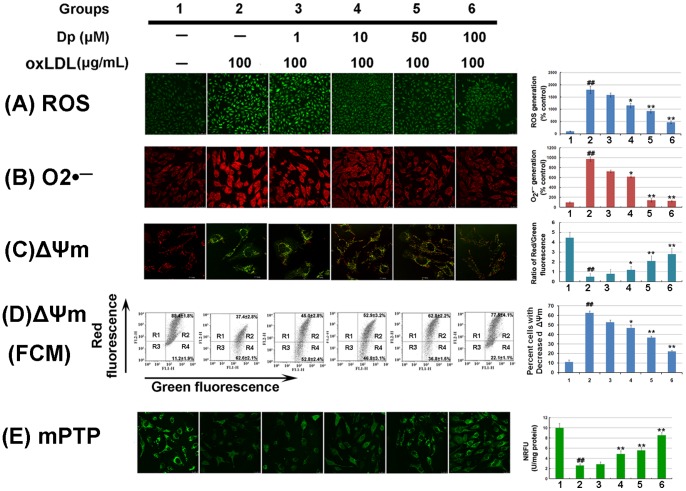
Effects of Dp on mitochondrial dysfunction in oxLDL-induced HUVECs.HUVECs were pretreated with various Dp concentrations (1, 10, 50 and 100 μM, respectively) for 2 h, and then exposed to 100 μg/mL of oxLDL for another 24 h. (A) Intracellular ROS levels were estimated using the probe DCFH-DA. Fluorescence was read at 485 nm for excitation and 520 nm for emission. (B) Intracellular O2
·− levels were estimated using the probe DHE. Fluorescence was read at 355 nm for excitation and 420 nm for emission. (C) Determination of ΔΨm was carried out using CLSM and fluorescences were determined by spectrophotometry assay. Red fluorescence is emitted by JC-1 aggregates in healthy mitochondria with polarized inner mitochondrial membranes, while green fluorescence was emitted by cytosolic JC-1 monomers and indicates ΔΨm dissipation. Merged images indicated the co-localization of JC-1 aggregates and monomers. The ΔΨm in each group was calculated as the ratio of red to green fluorescence. (D) ΔΨm was detected by flow cytometry assay. The designated R2 and R3 regions represent cell populations that exhibit high (R2) or low (R4) red-to-green fluorescence ratio, consistent with high and low Δψm, respectively. Results shown are one representative of three separate experiments and the proportion of cells in R3 regions were quantified and expressed as percent cells with decreased ΔΨm. (E) The mPTP opening was assayed using the calcein–cobalt quenching method. Different HUVEC groups were used to measure the normalized relative fluorescence units (NRFU) of calcein. Fluorescences were determined using an InfiniteTM M200 Microplate Reader (Tecan Group Ltd., Männedorf, Switzerland). All results are presented as means ± SEM. and images were representative of at least three independent experiments. ##P<0.05, versus the control group; *P<0.05, **P<0.01 versus oxLDL-treated group.